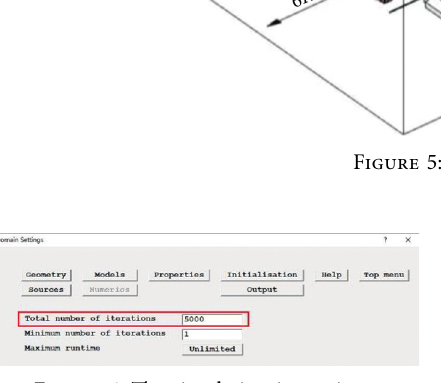
Figure 6: The simulation interations.